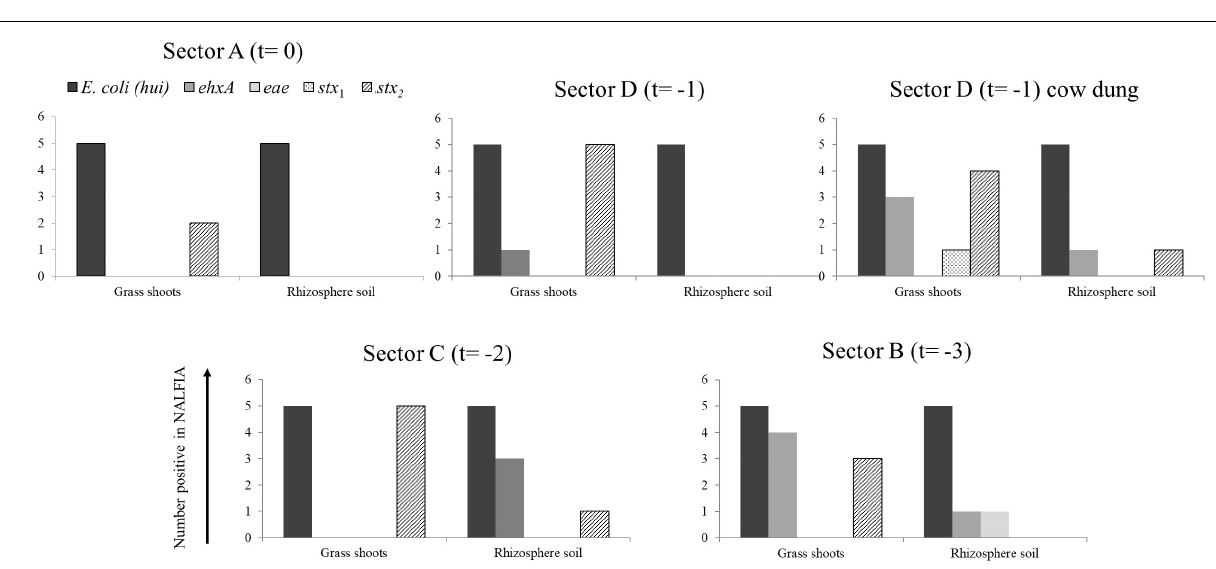
FIGURE 3 | Number of positive PCR-NALFIA reactions to E. coli 16S rRNA and virulence genes in DNA extracts from grass shoots, rhizosphere soil, and stable manure taken in different sectors of the pasture in August 2014 (A). Numbers on vertical axis represent the number of positive NALFIA reactions for each target gene in grass shoots and rhizosphere soil DNA extracts for each sector ( n =